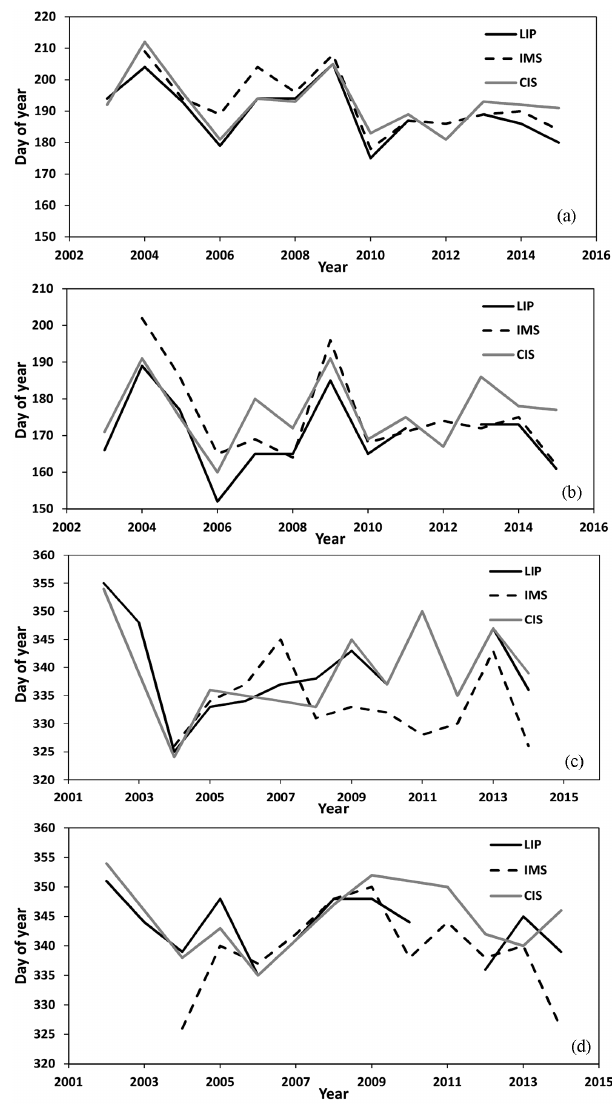
Figure 4. Comparisons of water clear of ice (WCI) dates for (a) Great Bear Lake and (b) Great Slave Lake and complete freeze over (CFO) dates for (c) Great Bear Lake and (d) Great Slave Lake, derived from the AMSR-E/2 Lake Ice Phenology (LIP) dataset de- veloped in this study. The LIP results are compared against similar metrics derived from the NOAA/IMS (IMS) and Canadian Ice Ser- vice (CIS). Missing LIP data from 2011 to 2012 denote the period between the end of AMSR-E operations and the start of the AMSR2